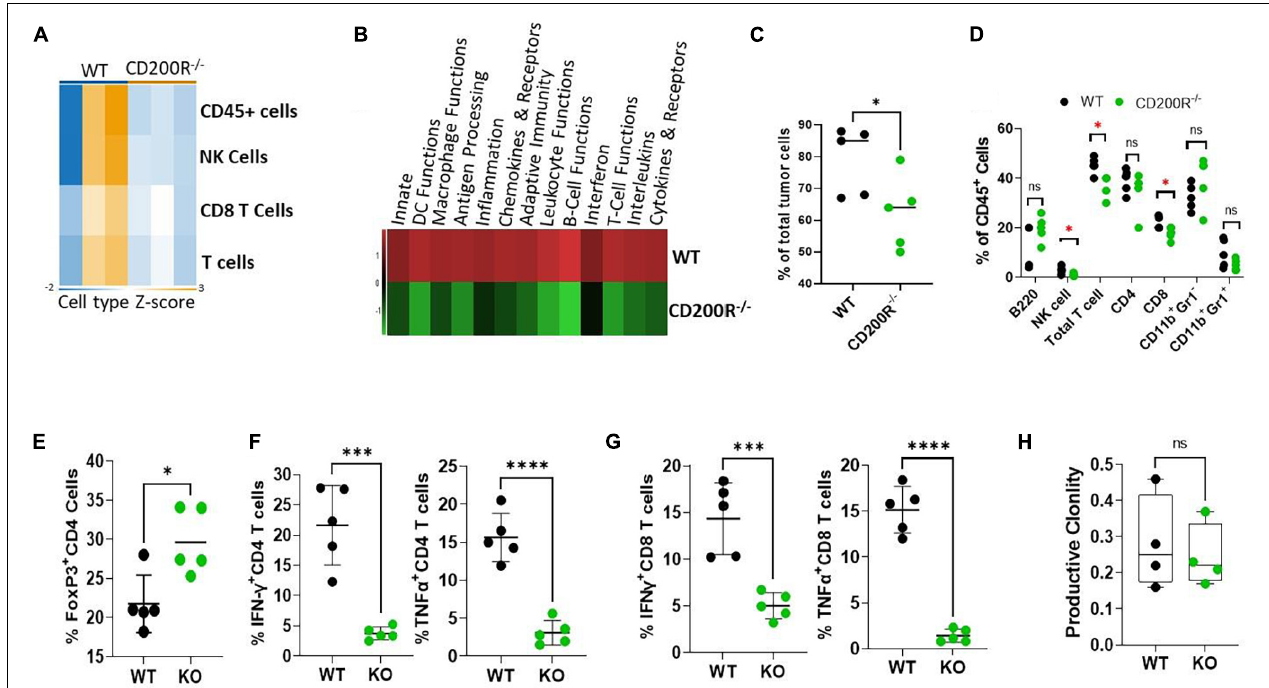
FIGURE 2 | Diminished anti-tumor T cell responses in Yumm1.7 tumors from CD200R − / − mice. (A,B) Nanostring analysis of tumors ( n = 3/group) from WT and CD200R − / − mice was performed using total tumor RNA and the Nanostring Pan cancer IO 360 panel, and results were analyzed using Rosalind software. Heat maps showing cell type abundance (A) in tumors and directed global significance scores (B) of altered pathways were generated based on Nanostring data. (C–G) Flow cytometry analyses of subtypes of tumor infiltrating leukocytes and effector functions of T cells. Percent of positive cells from each group was calculated relative to total tumor cells ( C , ∗ P = 0.046) or total CD45 + cells ( D , ∗ P < 0.05). Intracellular staining was performed to quantify Tregs ( E , ∗ P = 0.013), IFN- γ ( ∗∗∗ P = 0.0003) and TNF- α ( ∗∗∗∗ P < 0.0001) producing CD4 + (F) or IFN- γ ( ∗∗∗ P = 0.0009) and TNF- α ( ∗∗∗∗ P < 0.0001) producing CD8 + (G) T cells. (H) TCR-seq was performed on genomic DNA samples ( n = 4/group) from tumors grown in WT and CD200R − / − mice. Results were analyzed using ImmunoSEQ software. Depicted is productive clonality (higher values in this graph represent more clonal T cell response). Ns: not significant. Two sided Student’s t -test was used for all the statistical